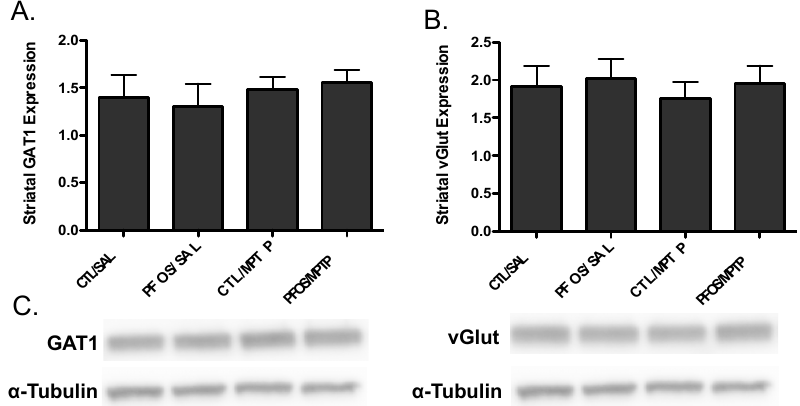
Figure 6. PFOS and MPTP do not alter the expression of GABAergic or glutamatergic proteins in the striatum. Neurotoxicological effects of PFOS appear to be preferential for dopaminergic terminals, as no change was observed in expression of GABAergic ( A ) or glutamatergic ( B ) presynaptic proteins in the striatum; and ( C ) representative imunoblots for vGAT and vGlut. α‐ Tubulin was included to ensure even protein loading. Columns represent means of raw data + SEM (six mice per treatment group).